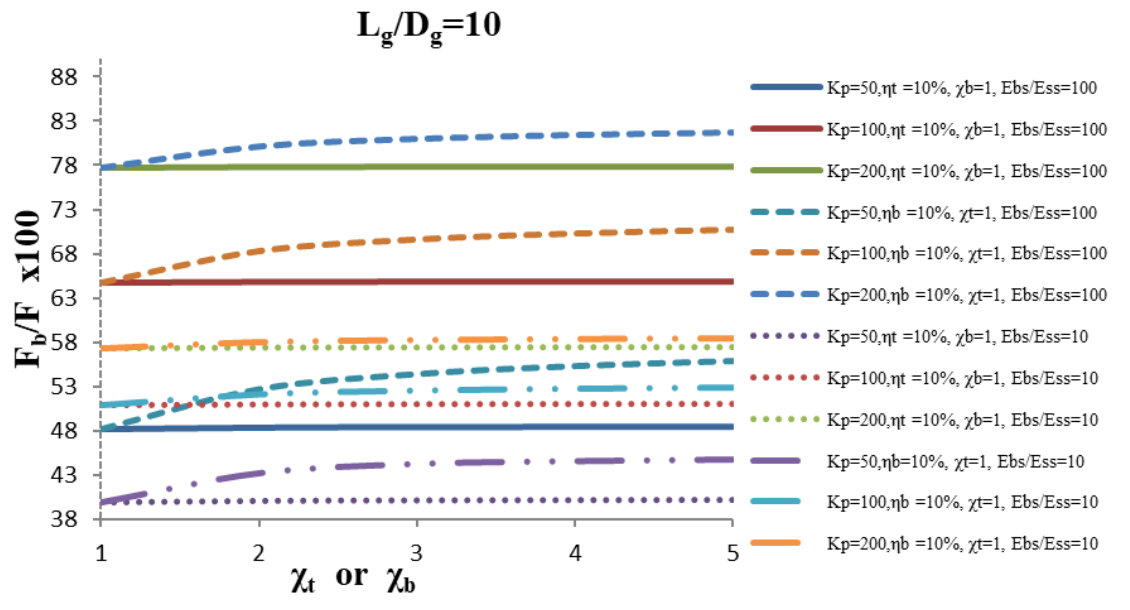
/F)x100 with strengthening factor for the top, χ b , and relative stiffness of bearing stratum, E p